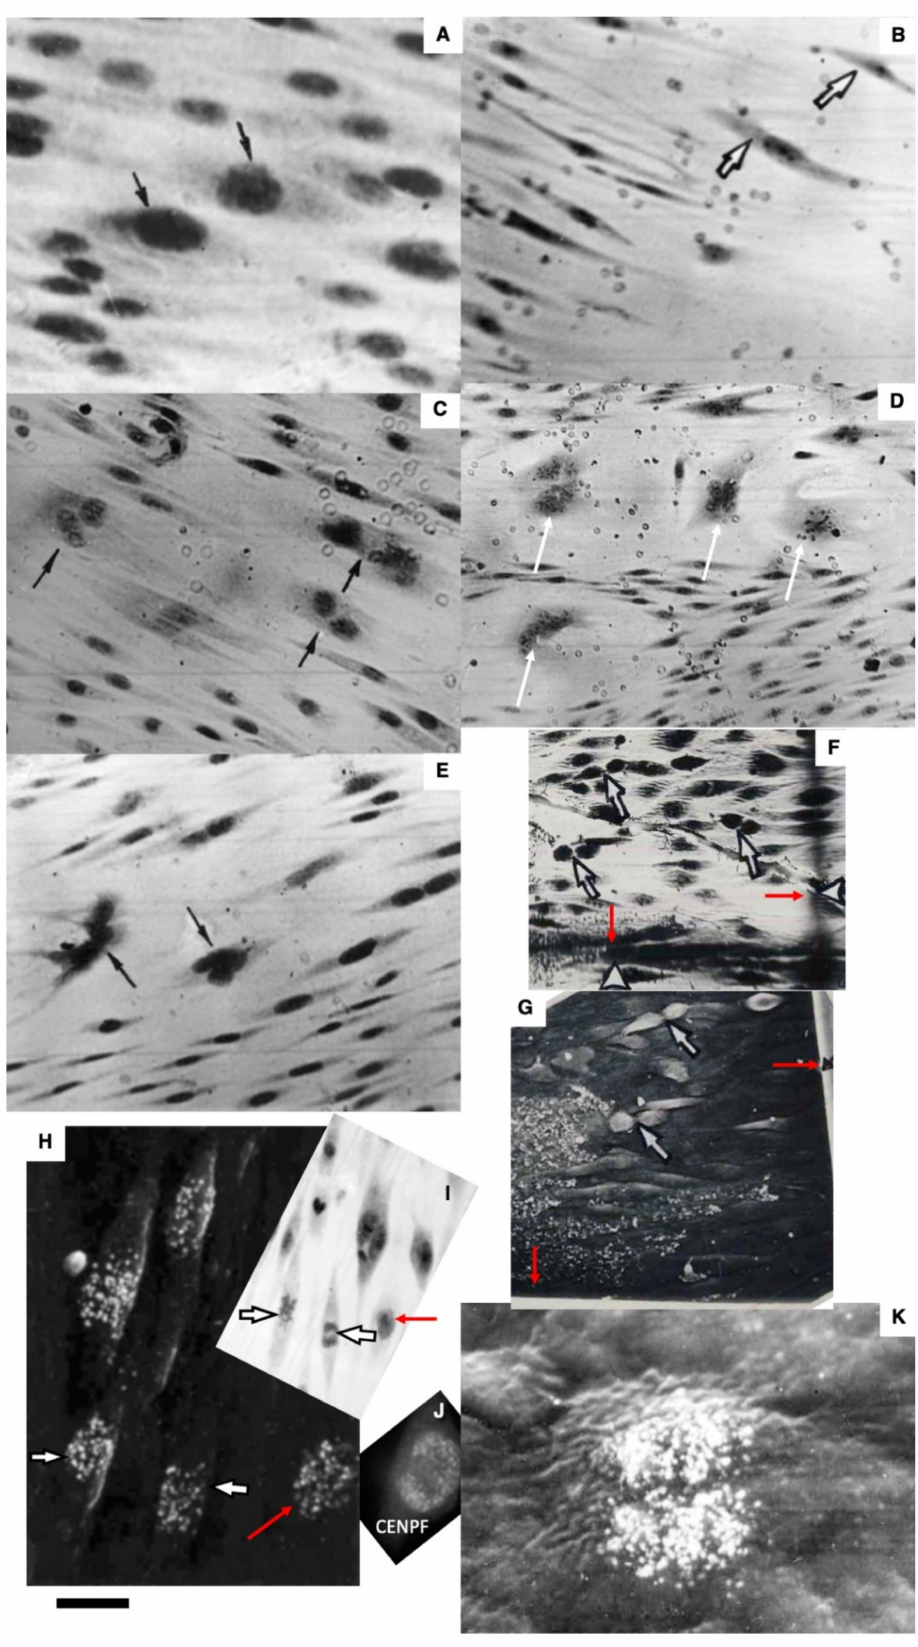
Figure 3. Methods of the correlative light electron microscopy (CLEM) based on en-face EC monolayers combined with SEM and the en-face analysis of aortic ECs. ( A ) Single injury. Arrows show EC in